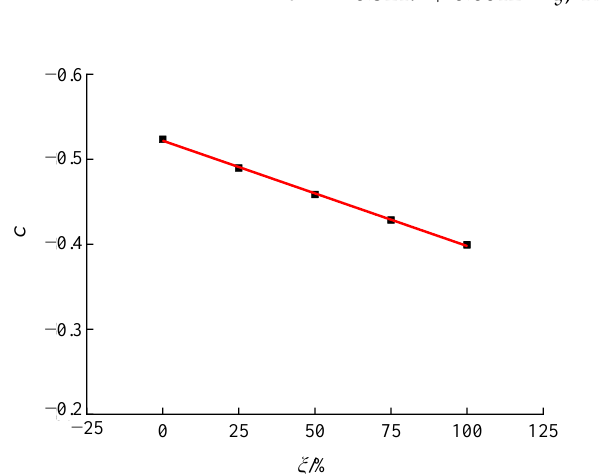
Figure 12. Relationship between the RA replacement rate and parameter c.